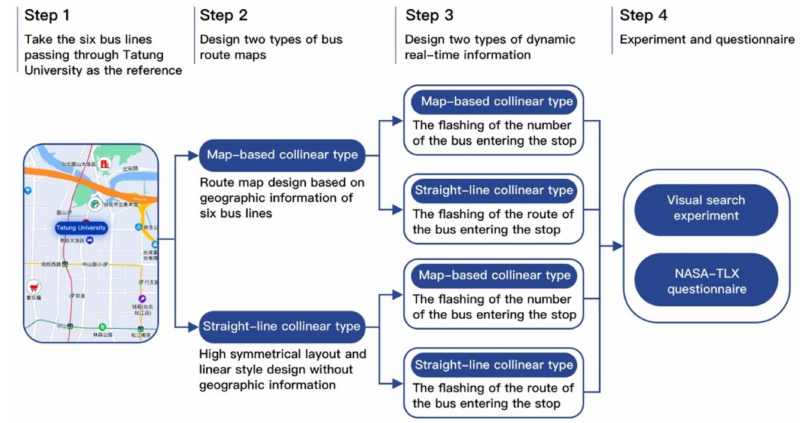
Figure 1. Research